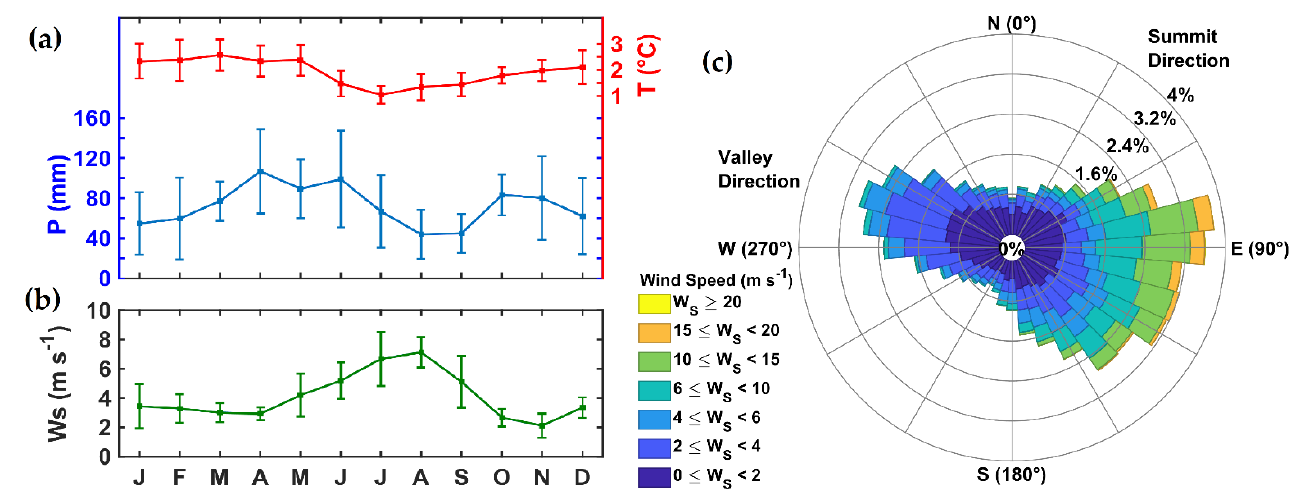
Figure 2. ( a ) Monthly precipitation values (blue line) measured at P8 rain gauge for 2005–2014 and 2019–2020 period. The same for air temperature (red line) measured at AWS PRAA station for 2010–2017 and 2019–2020 period. ( b ) Mean monthly wind speed (green line) at AWS PRAA station for 2012–2016 and 2019–2020 period. Verticals bars represent the monthly standard deviation computed for each cycle. ( c ) Wind rose displaying wind directions at the PRAA station for the 2019–2020 period. Table 1. Summary of 15 min data series at PRAA station for July 2019–July 2020 monitoring period. P5 and P95 correspond to percentile 5 and 95, respectively. Rain rate corresponds to measured values at Parsivel disdrometer. P05 and P95 are the percentiles 5 and 95,